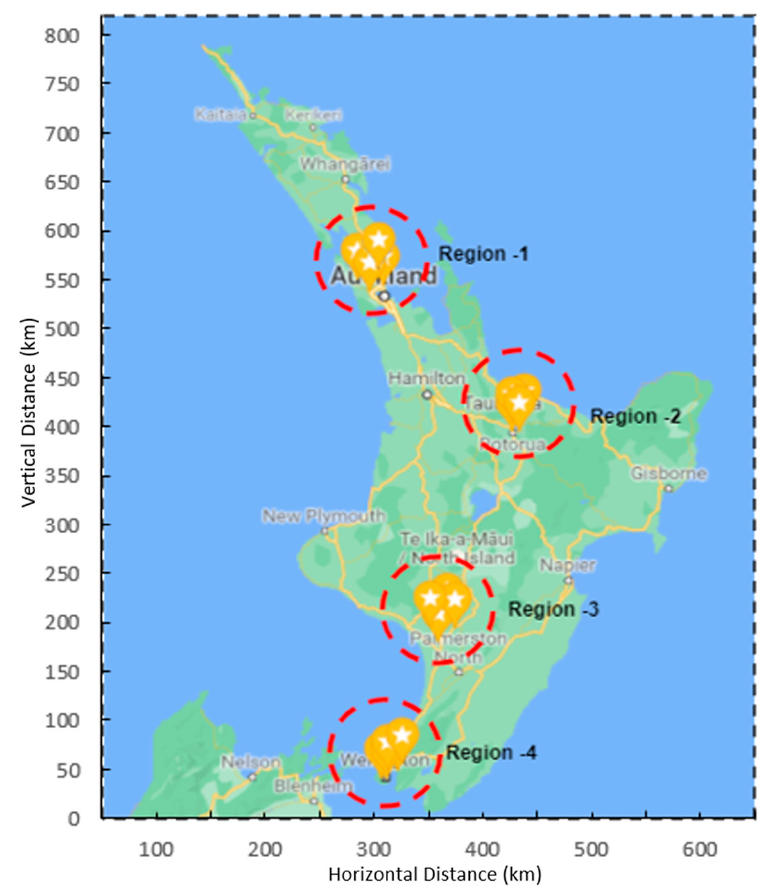
Figure 9. Sensors installed in different regions of New Zealand.